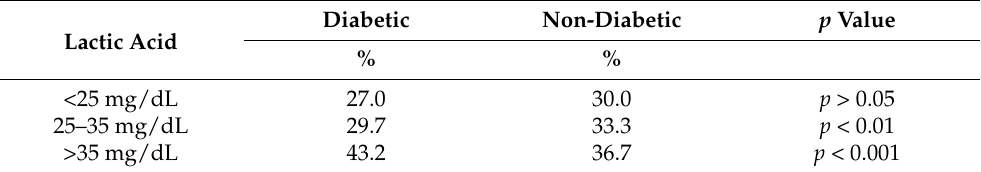
Table 5. Lactic acid value. Lactic